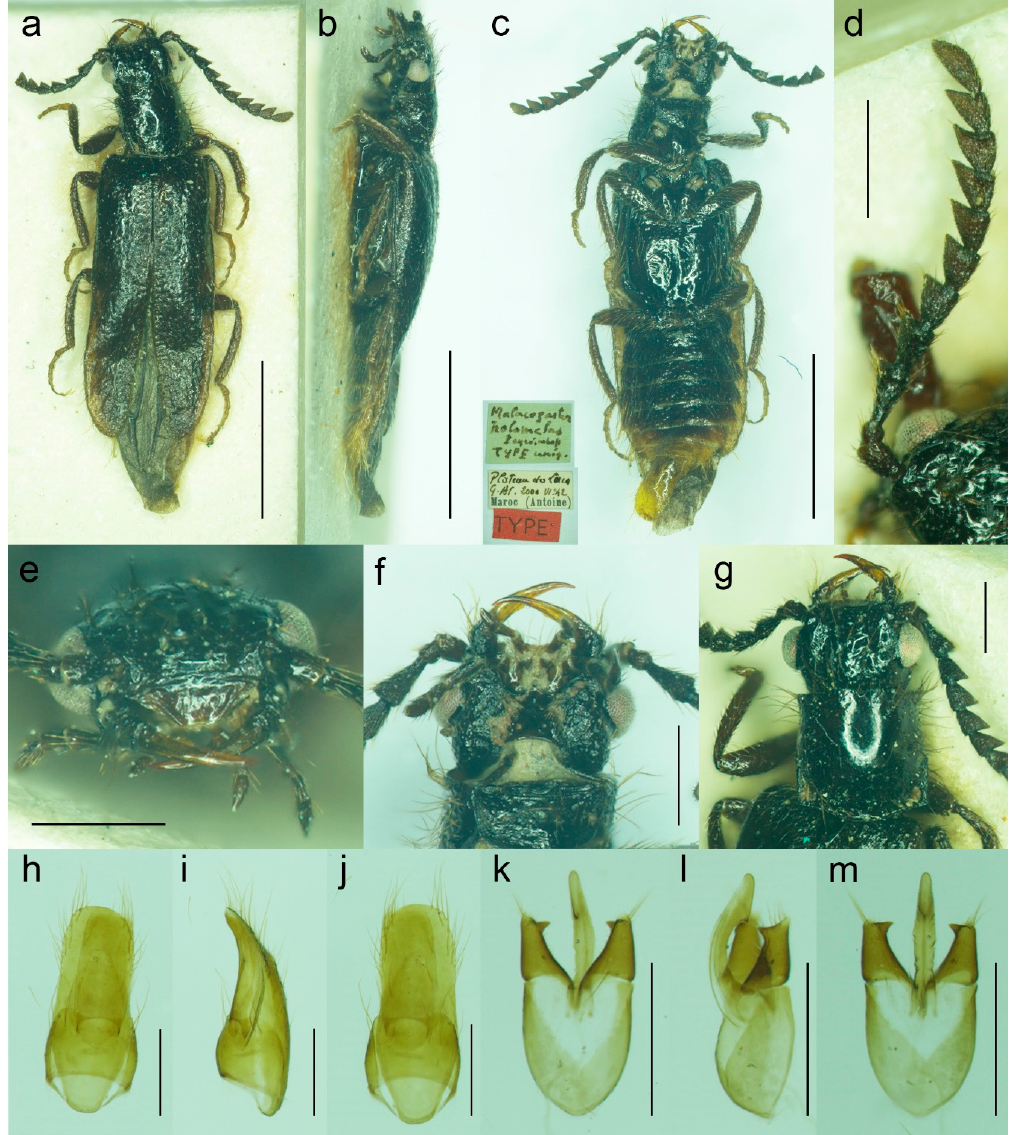
Figure 8. Malacogaster holomelas Peyerimhoff, 1949, male holotype. ( a ) Habitus, dorsal view; ( b ) habitus, lateral view; ( c ) habitus, ventral view; ( d ) right antenna; ( e ) head, frontal view; ( f ) head, ventral view; ( g ) pronotum, dorsal view; ( h ) genital capsule formed by tergites IX and X, and sternite IX, dorsal view; ( i ) genital capsule formed by tergites IX and X, and sternite IX, lateral view; ( j ) genital capsule formed by tergites IX and X, and sternite IX, ventral view; ( k ) aedeagus, dorsal view; ( l ) aedeagus, lateral view; ( m ) aedeagus, ventral view. Scale bars = ( a – c ) 2.0 mm; ( d – m ) 0.5 mm.